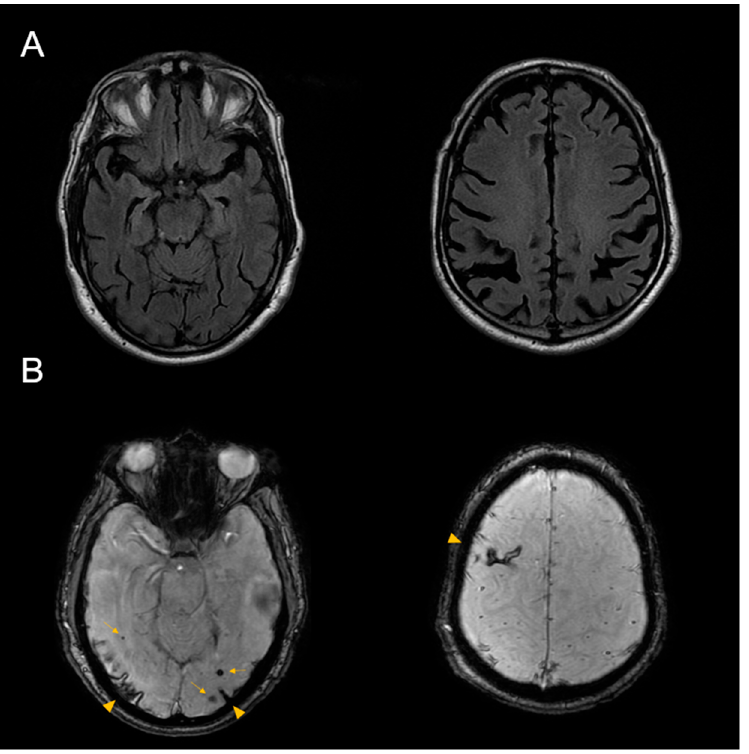
Figure 3. Brain MRI from case 1. ( A ) Axial fluid-attenuated inversion recovery (FLAIR) sequence shows global atrophy, predominantly involving both parietal lobes. ( B ) Susceptibility weighted imaging (SWI) sequence shows right frontal and bilateral occipital superficial siderosis (arrow heads). Multiple lobar microhemorrhages were also present (arrows).